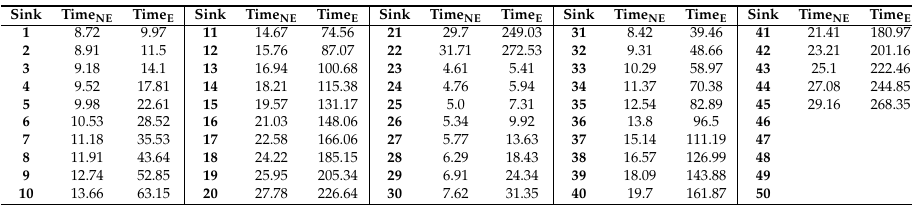
Table A6. Scenario 1: transmission times (in s) for each sink all over the transmission line. (Distance between poles is equal to 200 m, κ = 2, η = 22, η = 23, NE means no encryption, E means encryption.)